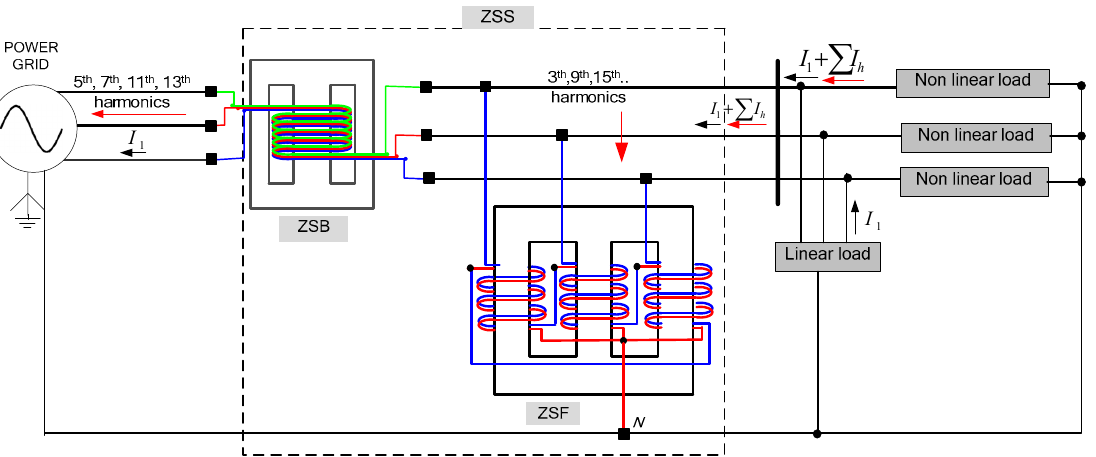
Figure 1. Zero-sequence suppressor (ZSS) composed by the zero-sequence filter (ZSF) and the zero-sequence blocker (ZSB).